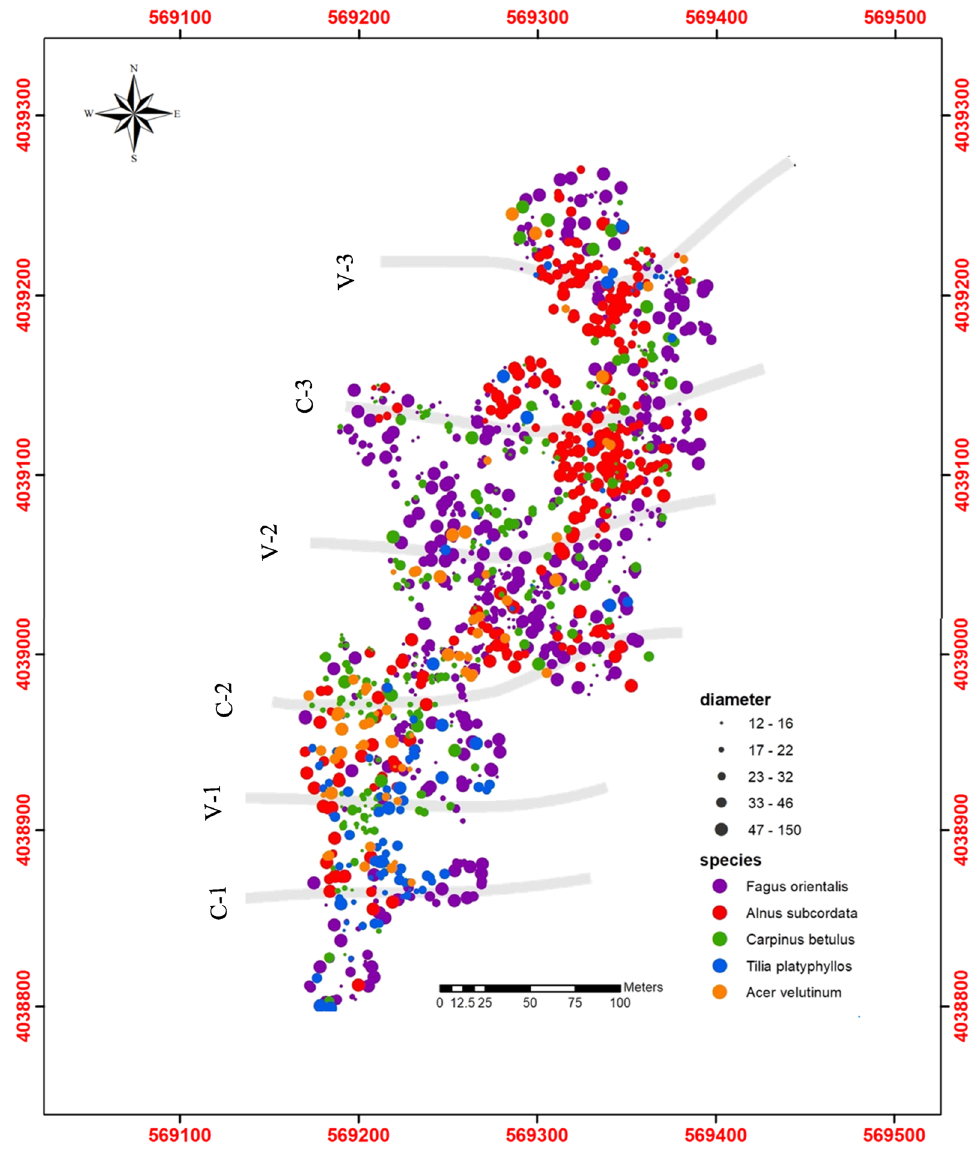
Figure 5. Spatial distribution of five species by diameter class; beech ( Fagus orientalis ), alder ( Alnus subcordata ), linden ( Tilia platyphyllos ), Persian maple ( Acer velutinum ), hornbeam ( Carpinus betulus ). The isolines are catenas (six C- and V-shaped) derived from the profile curvature map.